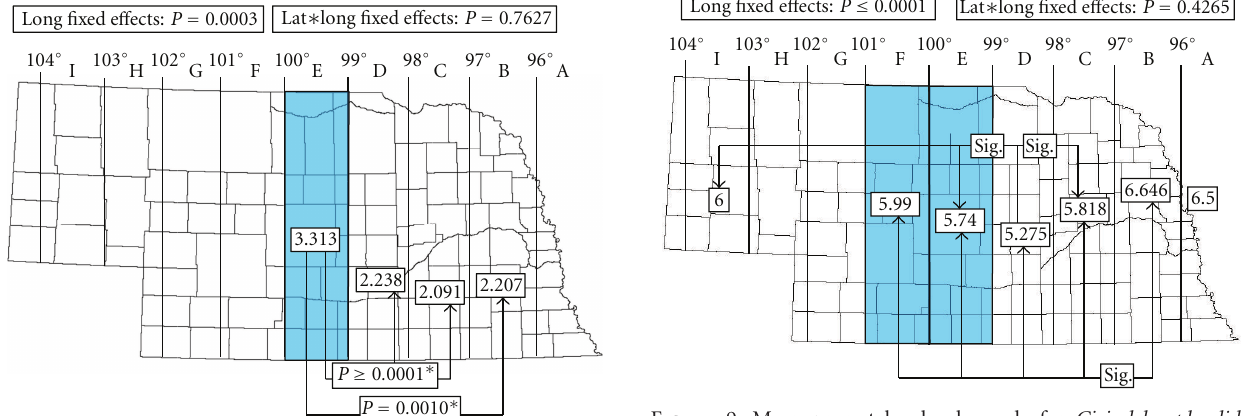
Figure 9: Mean pronotal color by code for Cicindela splendida by longitudinal region. Significant di ff erences between longitudes shown by arrows and mean value presented in each longitudinal grouping. Fixed e ff ects presented at top. No latitude by longitude interactions found. Shaded area depicts longitudinal regions di ff er- ing from all others except each